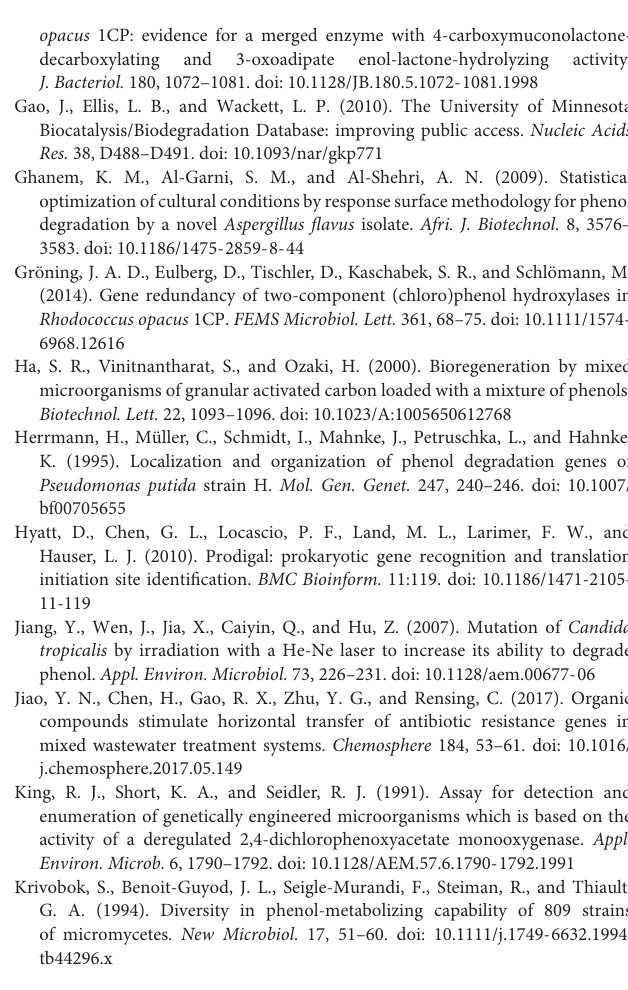
Supplementary Table 2 | General features of A. lwoffii NL1